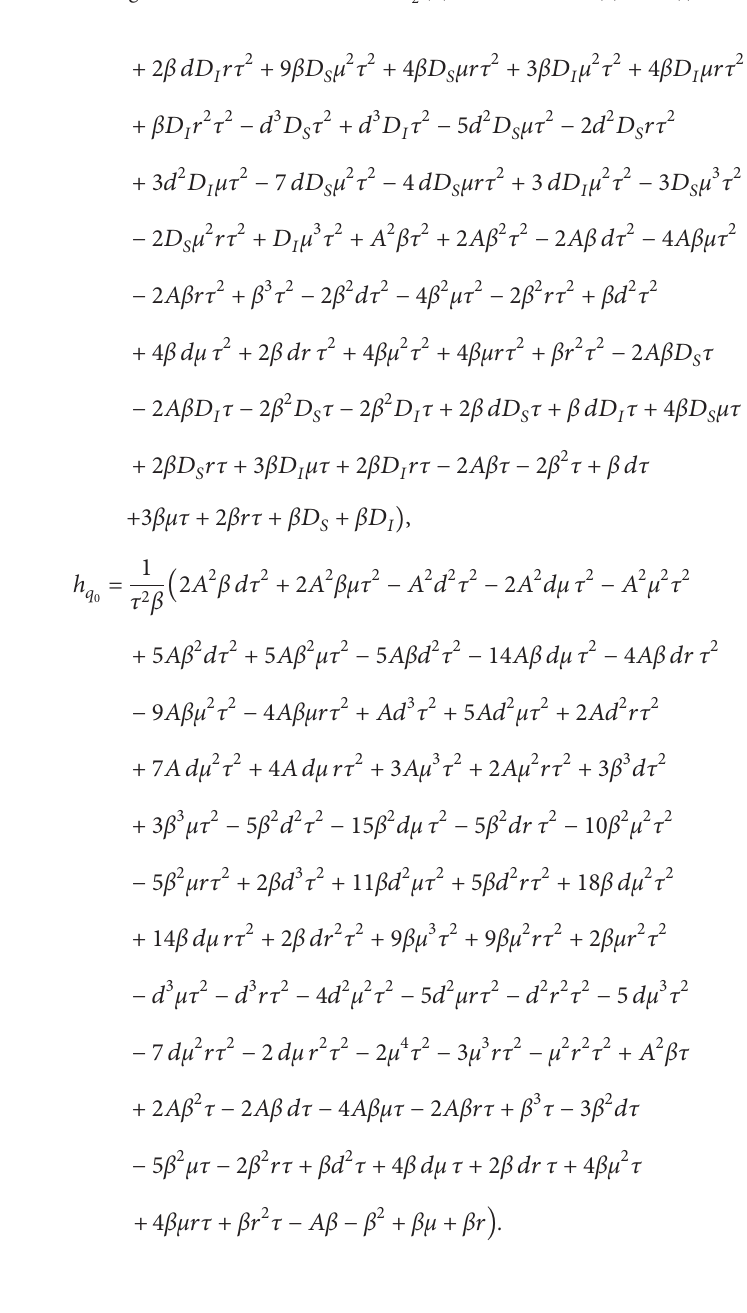
Figure 1: The diagrams of the cubic function H